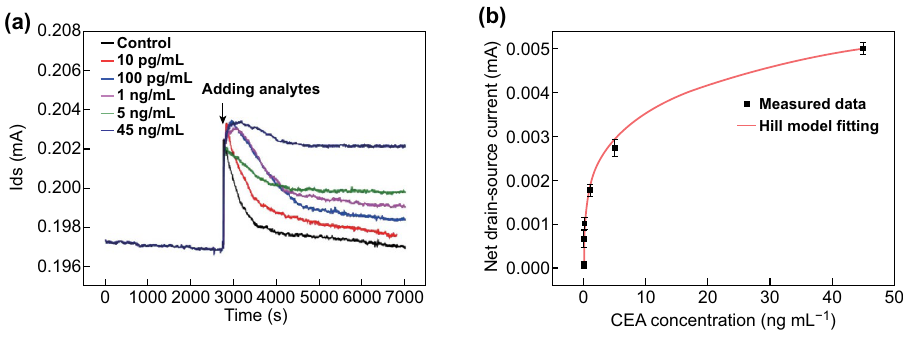
Fig. 5 a Drain–source current of the anti‑CEA‑dBSA functionalized GFET in the presence of CEA concentrations of 10 pg mL −1 , 100 pg mL −1 , 1 ng mL −1 , 5 ng mL −1 , and 45 ng mL −1 . b Net drain–source current at different CEA concentrations fitted with a curve (red line) of the Hill adsorption model. (Color figure